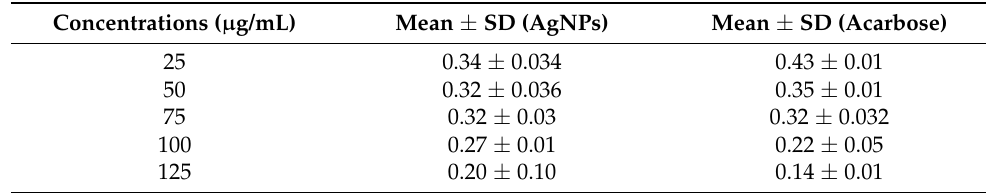
Figure 8. Shows a linear relationship between concentrations of BP-AgNPs and percentage inhibition of alpha-amylase. Acarbose is treated as a positive control. The experiment was performed in triplicate and mean ± SD was calculated. All the values are statistically significant ( p < 0.05). Table 3. Values represented in (Mean ± SD) and significant level ( p < 0.05), through one-way ANOVA of alpha-amylase assay.